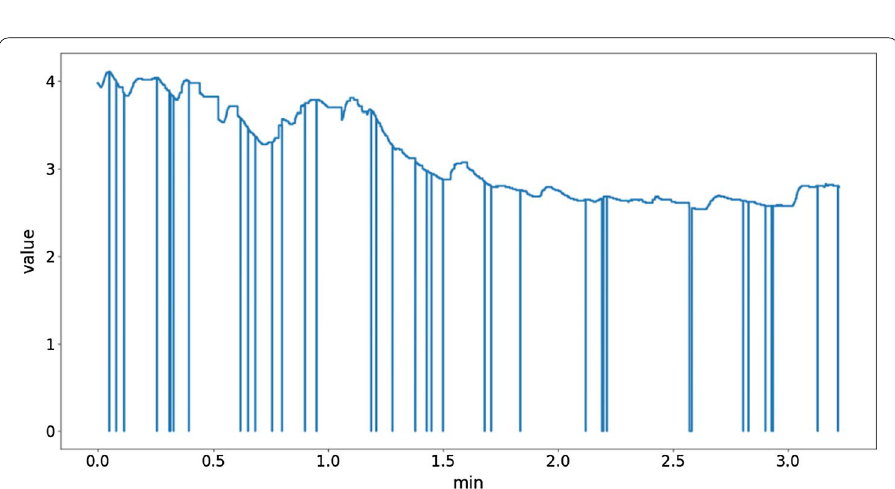
Fig. 10 The value of GSR during experiment for a